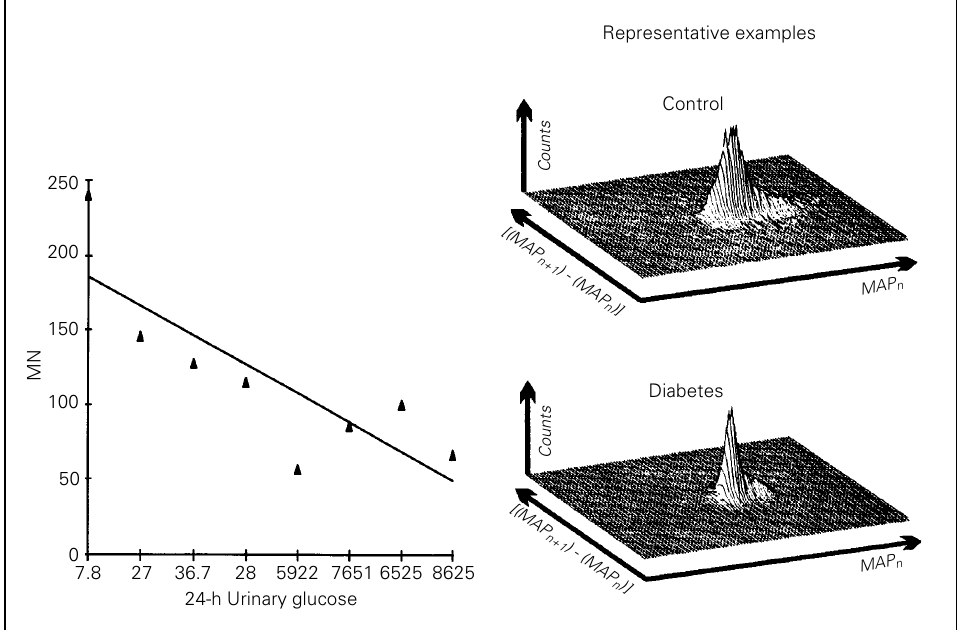
Figure 1 - Left panel , Scatter- gram representing 24-h urinary glucose and the MN index of diabetic and control rats 7 days after streptozotocin. Right panel , A three-dimensional re- turn map of one control and one diabetic